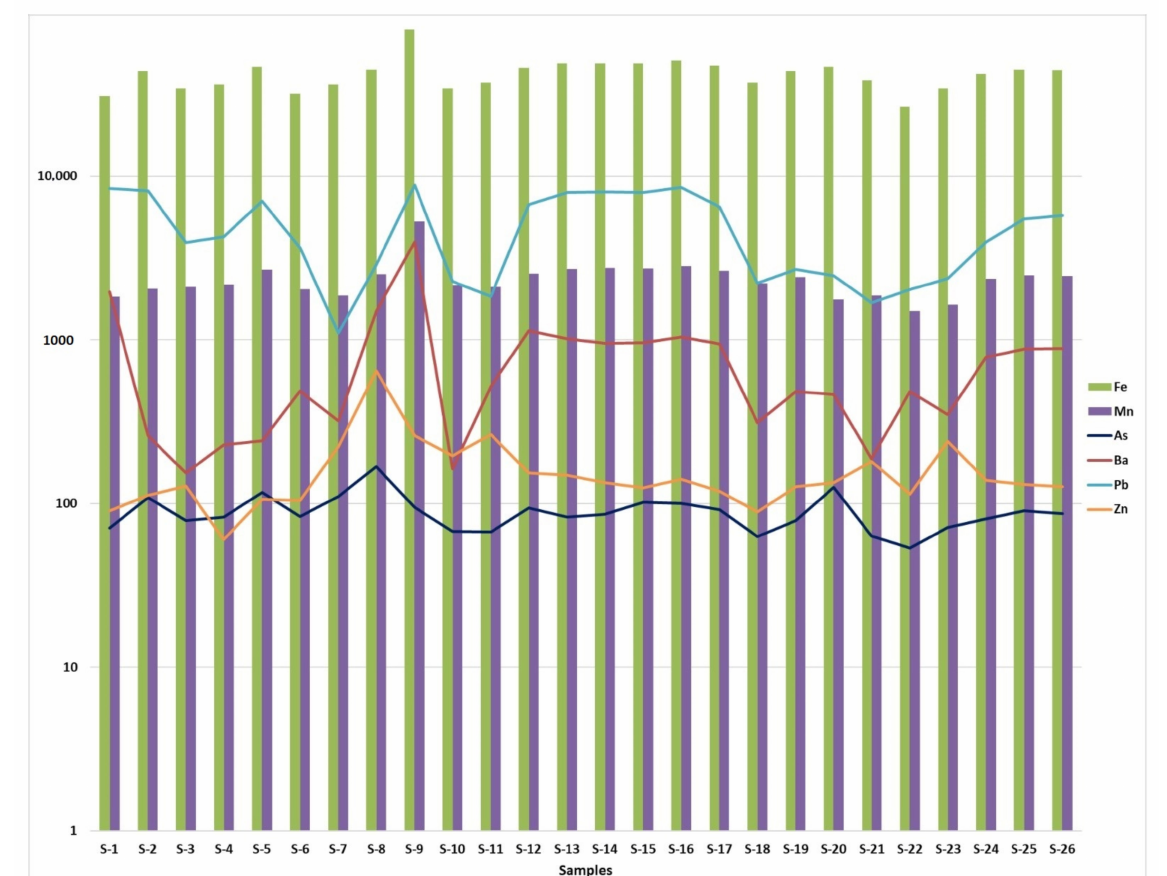
Figure 4. Distribution of the concentrations (expressed in logarithmic scale in base 10) of As, Ba, Fe, Mn, Pb, and Zn along the slope of the tailing